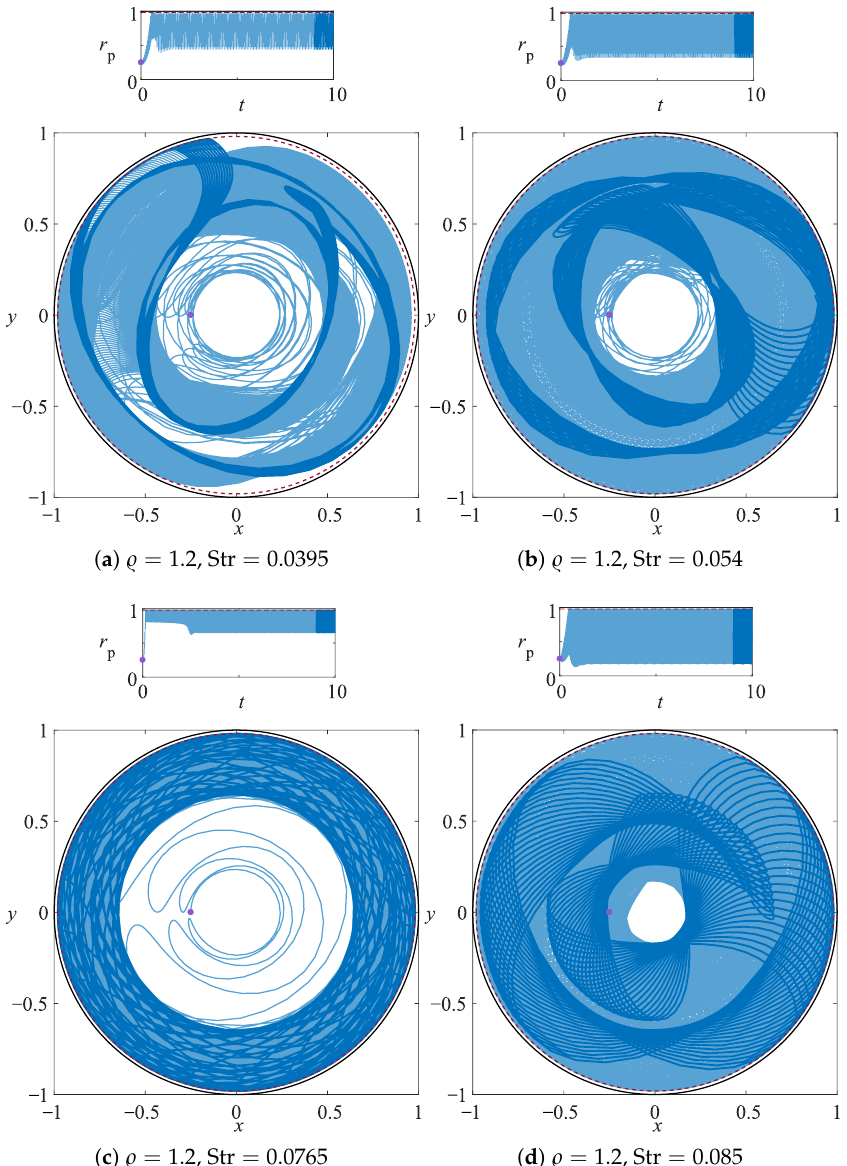
Figure 7. Radial coordinate r p of a particle trajectory for (cid:36) = 1.2, St = 1 and Str = 0.0395, 0.054, 0.0765, and 0.085. The trajectories are integrated for t = 10 and they are denoted by the light-blue line. The darkblue solid line shows the last 10% of the particle orbit and the purple dot its initial position. The red dashed line identifies the sliding surface of the PSI model, which surface is at distance ∆ = a from the driving